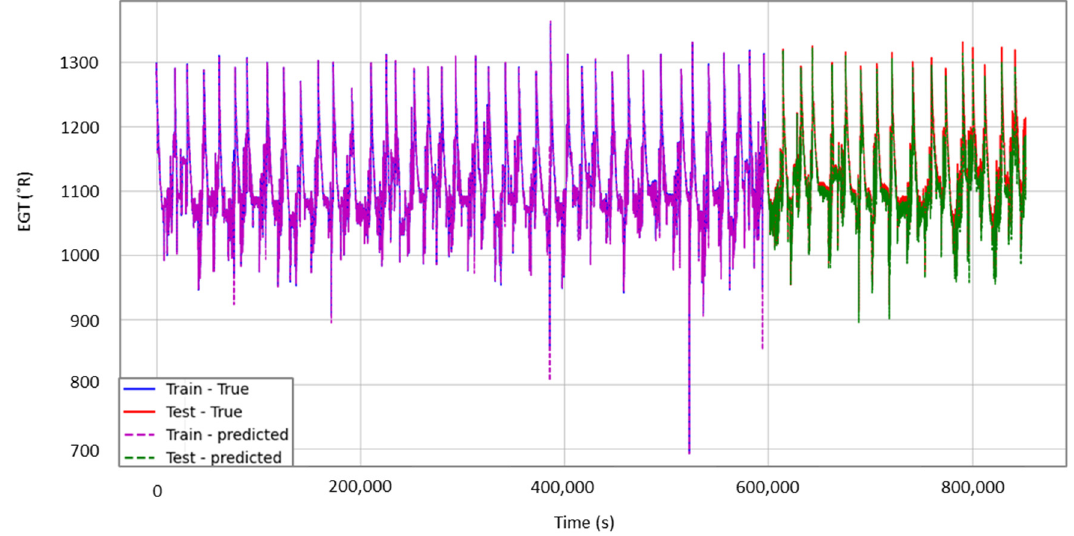
Figure 10. T50 (EGT) prediction for unit 13 of DS08a.